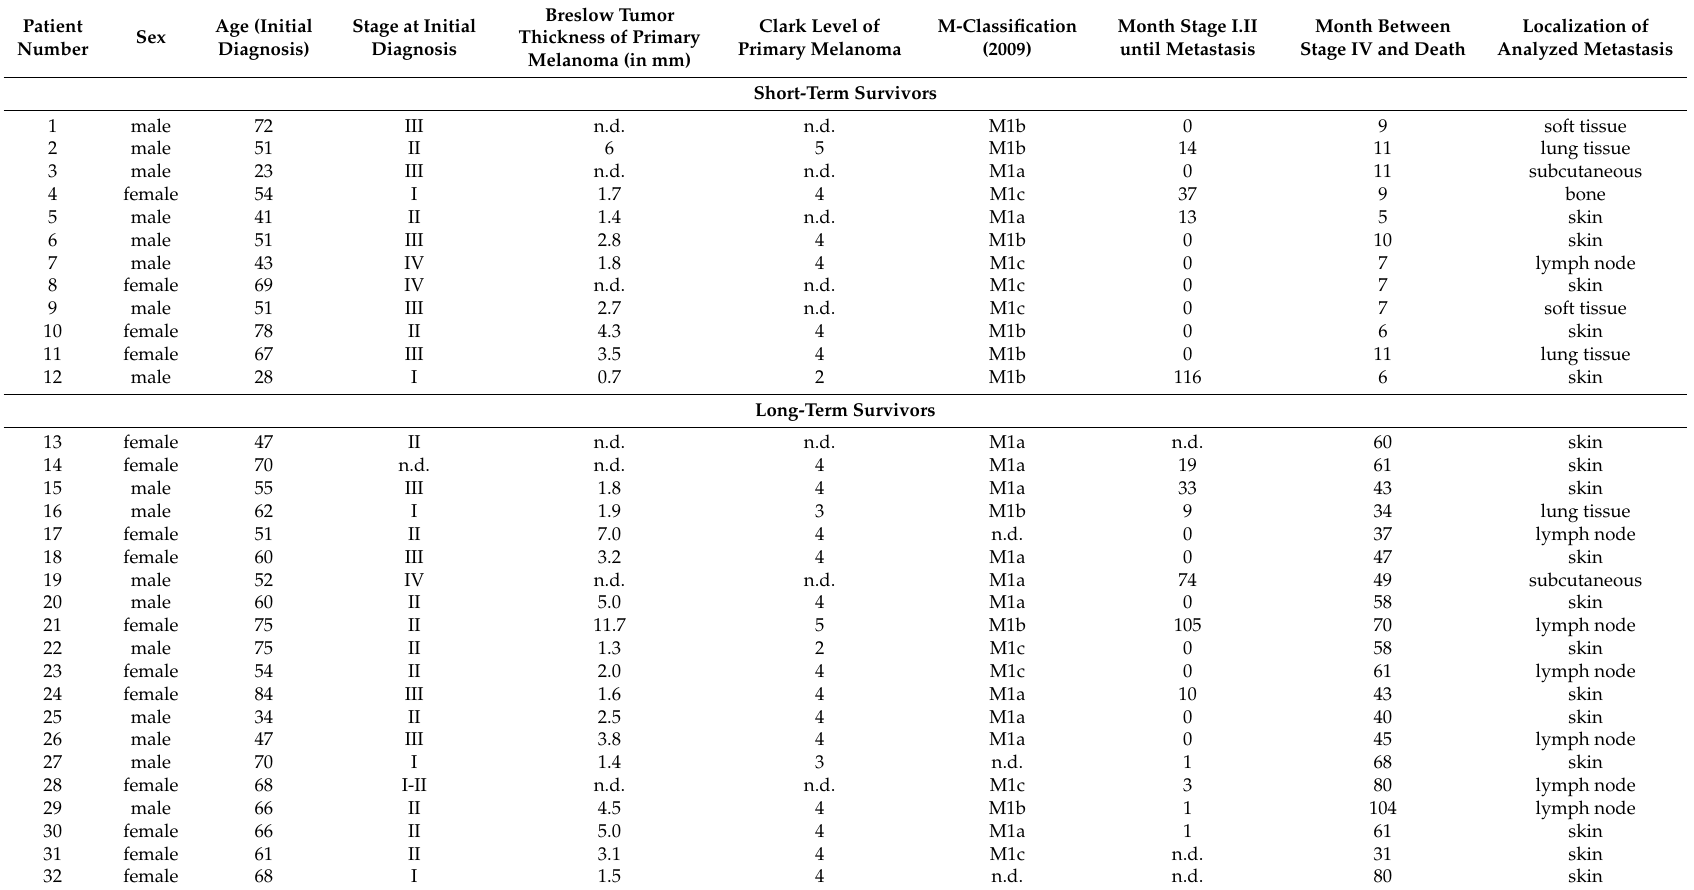
Table 6. Clinical data of stage I6 melanoma short-term survivors and long-term